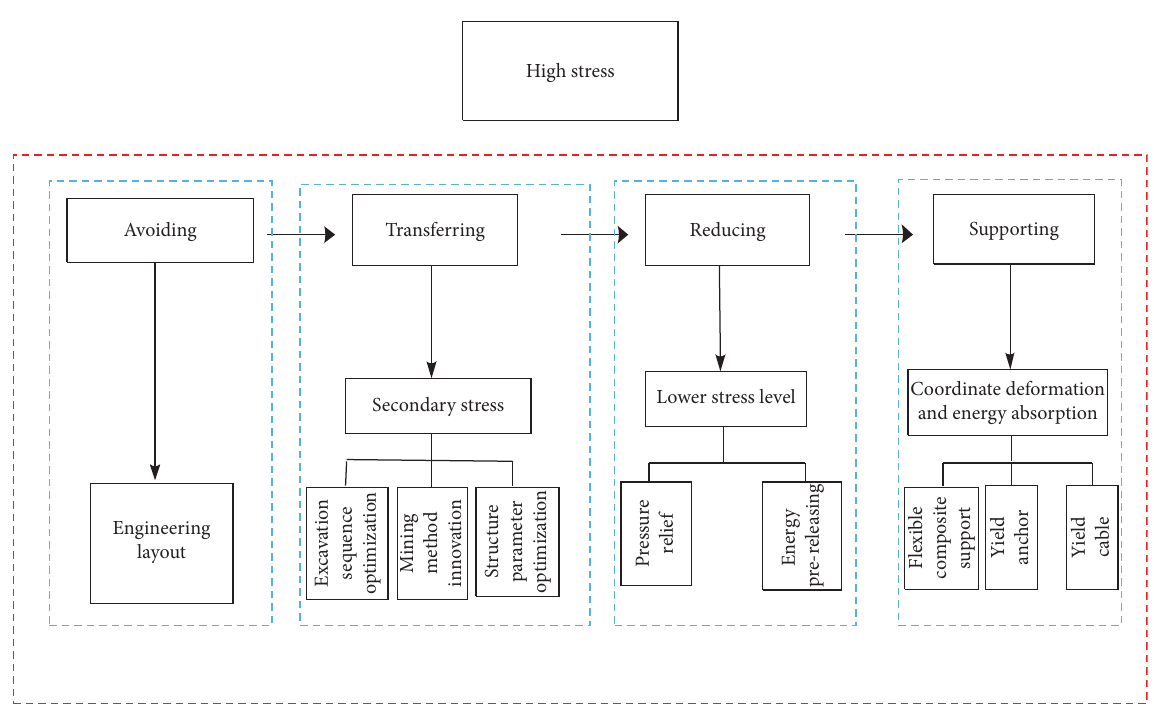
Figure 1: Strategy and system of technical methods for ground failures control.